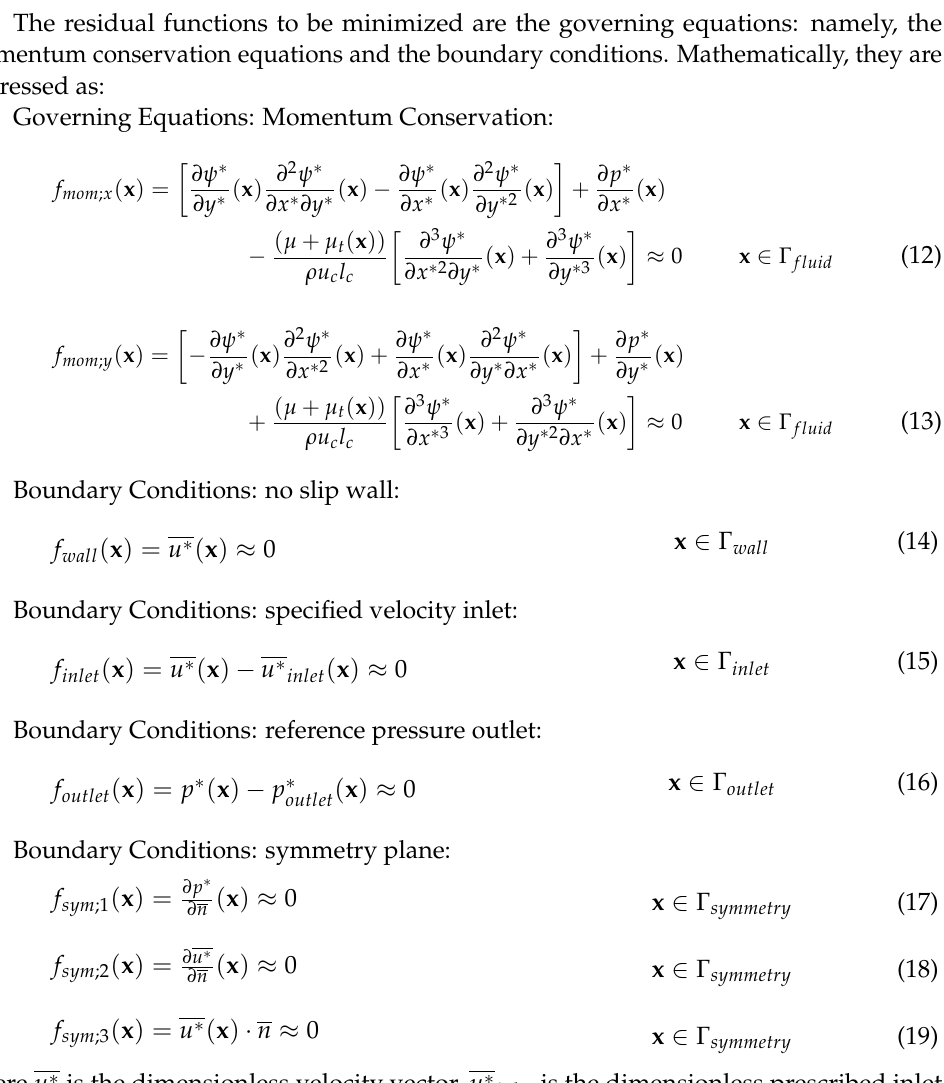
Figure 4. Collocation points where the PINN loss function is evaluated. Boundary condition residuals are only evaluated at points placed on the corresponding